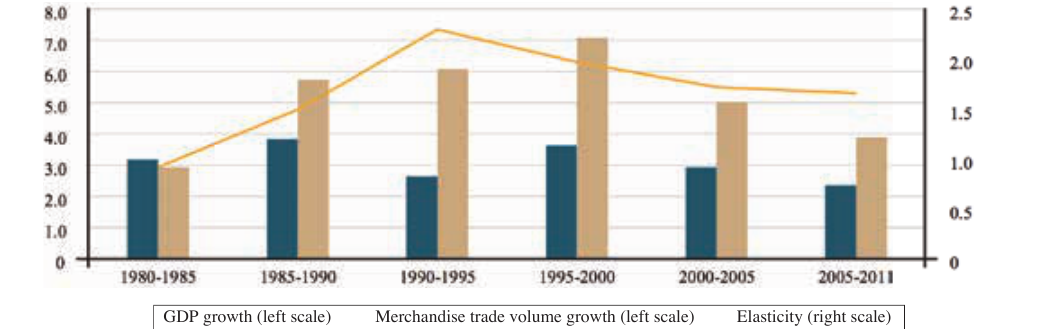
Figure 1 . WTO Secretariat.